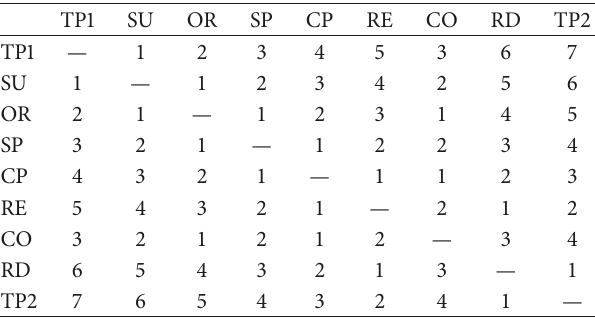
Table 6: Distance matrix for the modified layout [ 𝐷 2